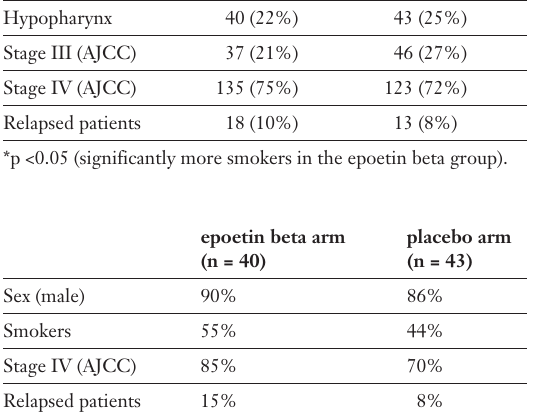
Certain demographic characteristics of pa- tients in Henke’s study [47].